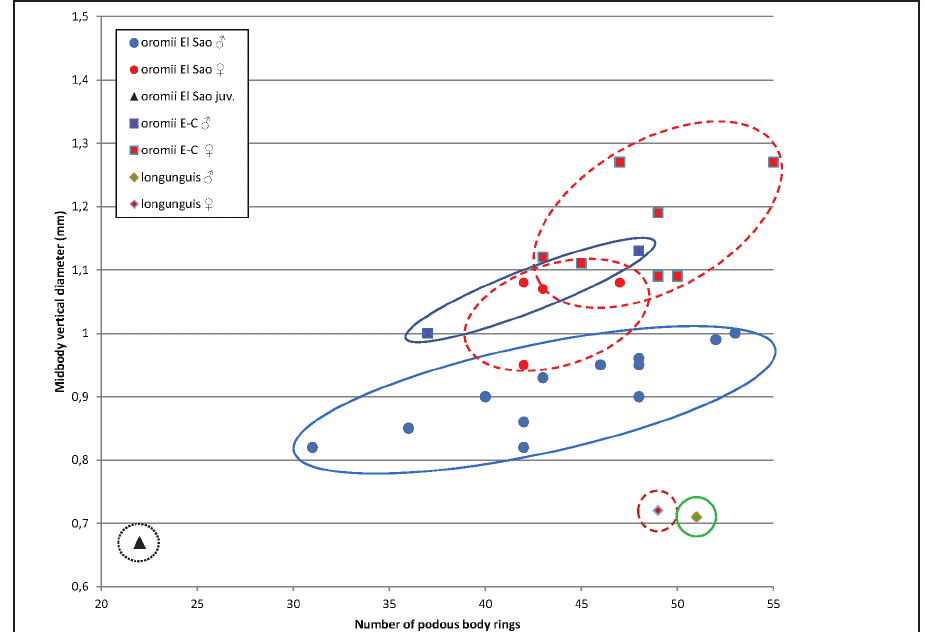
Fig. 5. Size diagram for Dolichoiulus oromii sp. nov. and D. longunguis sp. nov. The diagram shows number of podous (leg-bearing) body rings (p.r., x axis) and vertical body diameter in mm (y axis). For a given number of podous rings D. oromii sp. nov. is thicker than D. longunguis sp. nov. but thinner than D. typhlocanaria sp. nov. (see Fig. 1); specimens of D. oromii sp. nov. from East-Central Gran Canaria are thicker than those from the Northwest (El Sao), and females are thicker than